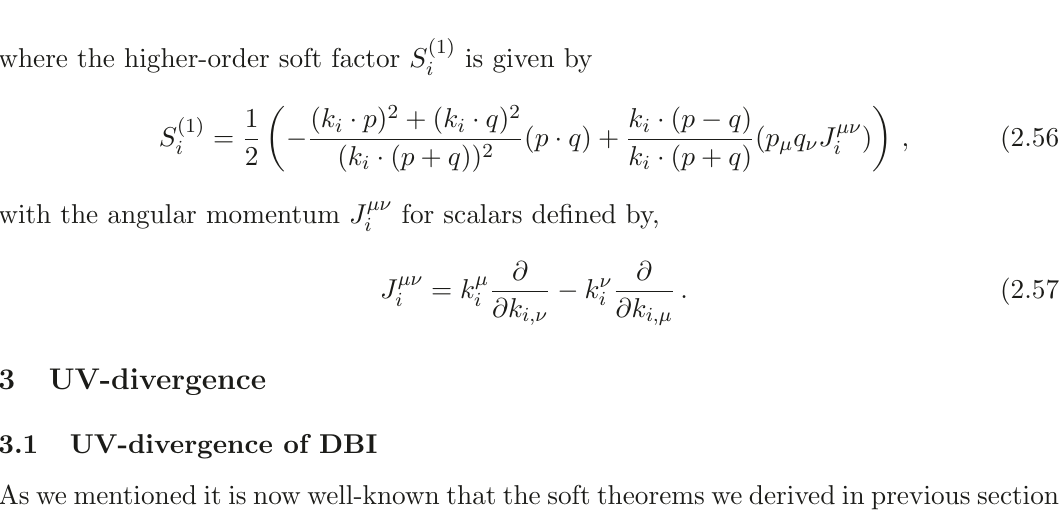
Figure 1 . The Feynman diagrams contribute to four and six-point amplitudes in DBI at one-loop order. One should also sum over all other independent